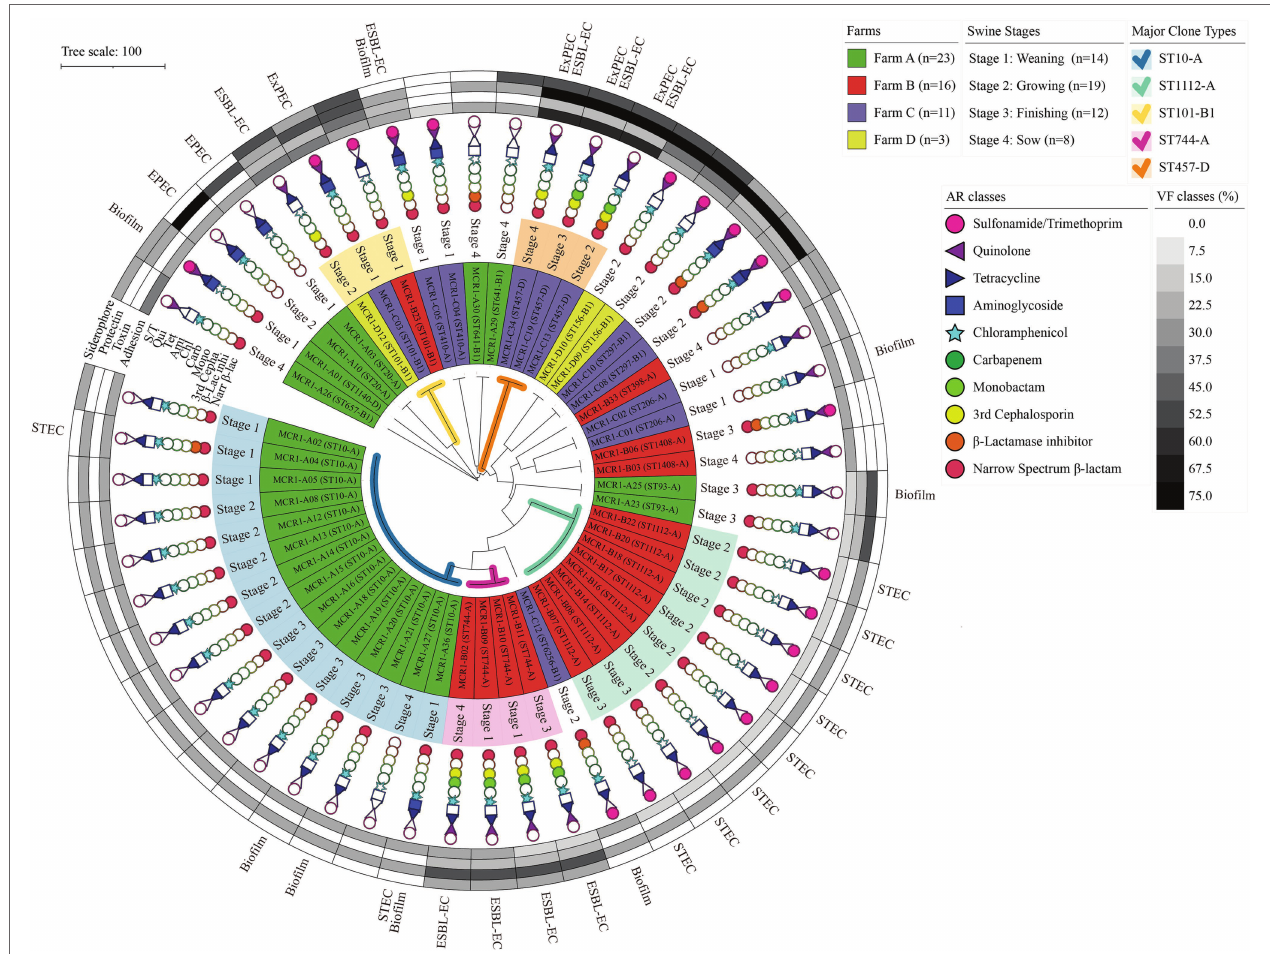
FIGURE 3 | Antimicrobial resistance, genotypic/phenotypic virulence factors, and clone types of 53 MCR1-EC isolates from swine farms. Visualization was conducted using the online visualization tool iTOL (v6, https://itol.embl.de/). MCR1-EC, Escherichia coli carrying the mobilized colistin resistance gene mcr-1.1 ; EPEC, enteropathogenic E. coli ; STEC, shiga toxin-producing E. coli ; and ESBL-EC, extended-spectrum β -lactamase producing E. coli , Biofilm, E. coli with moderate/strong biofilm formation